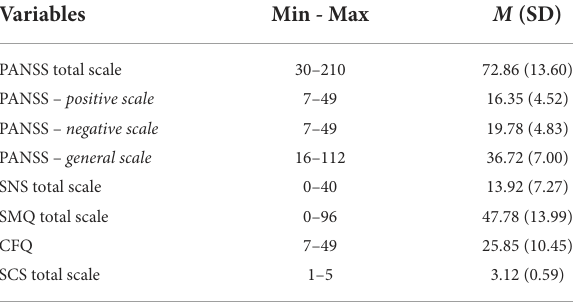
TABLE 4 Descriptive statistics of questionnaire